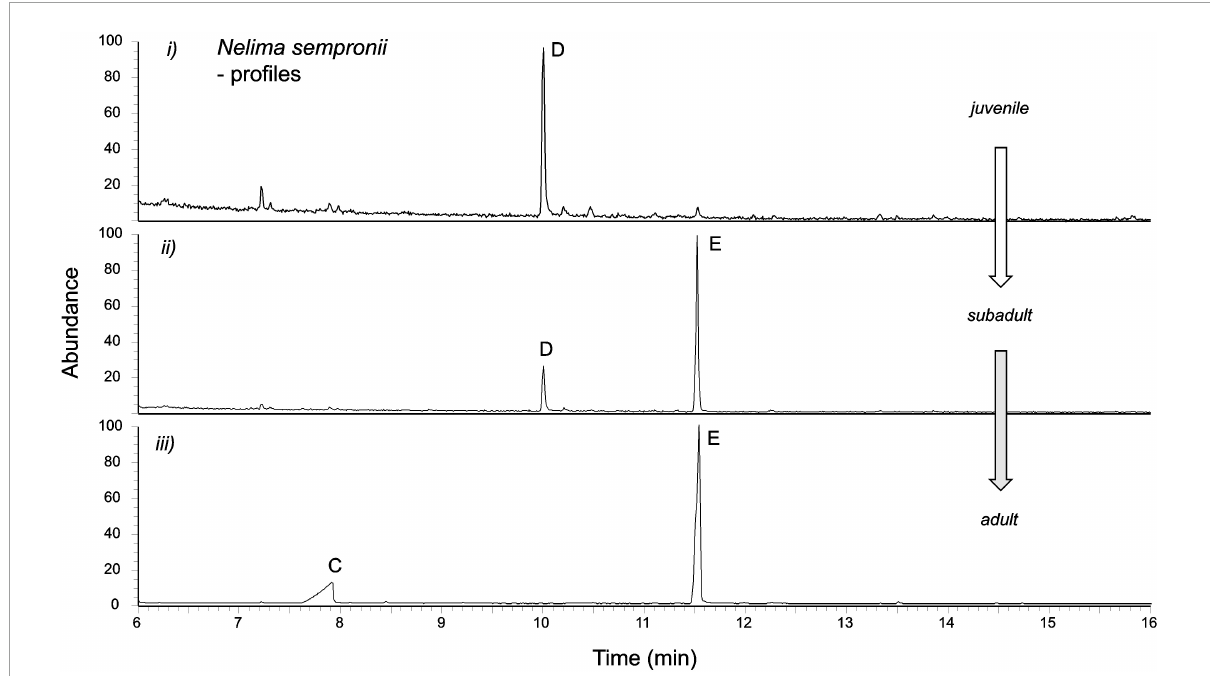
FIGURE2 Chromatographic profiles of European Nelima sempronii show unusual aromatic compounds 4-phenyl-2-butanone and 2-methyl-1-phenyl-pentan-3-one along with juvenile-adult polymorphism. Compounds: C [(2 R ,4 R )-2,4-dimethylhexanoic acid); D (4-phenyl-2-butanone); E (2 R )-2-methyl-1-phenyl-pentan-3-one)]. (i) 4-Phenyl-2-butanone (compound D) prevails in the secretions of juveniles, while 2-methyl-1-phenyl-pentan-3-one (compound E) lacks or is present in traces only. (ii) In subadults, 4-phenyl-2-butanone diminishes, while 2-methyl-1-phenyl-pentan-3-one increases. (iii) In the adults of N. sempronii , 4-phenyl-2-butanone has been completely replaced by 2-methyl-1-phenyl-pentan-3-one. Males and females show the same pattern. Adults generally show an additional, non-aromatic compound C [=(2 R ,4 R )-2,4-dimethylhexanoic